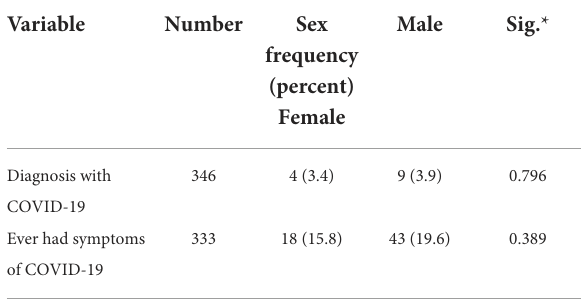
TABLE 6 Relationship between COVID-19 anamnesis and sex among respondents of self-reported side effects of COVID-19 vaccines, Ethiopia, 2021.